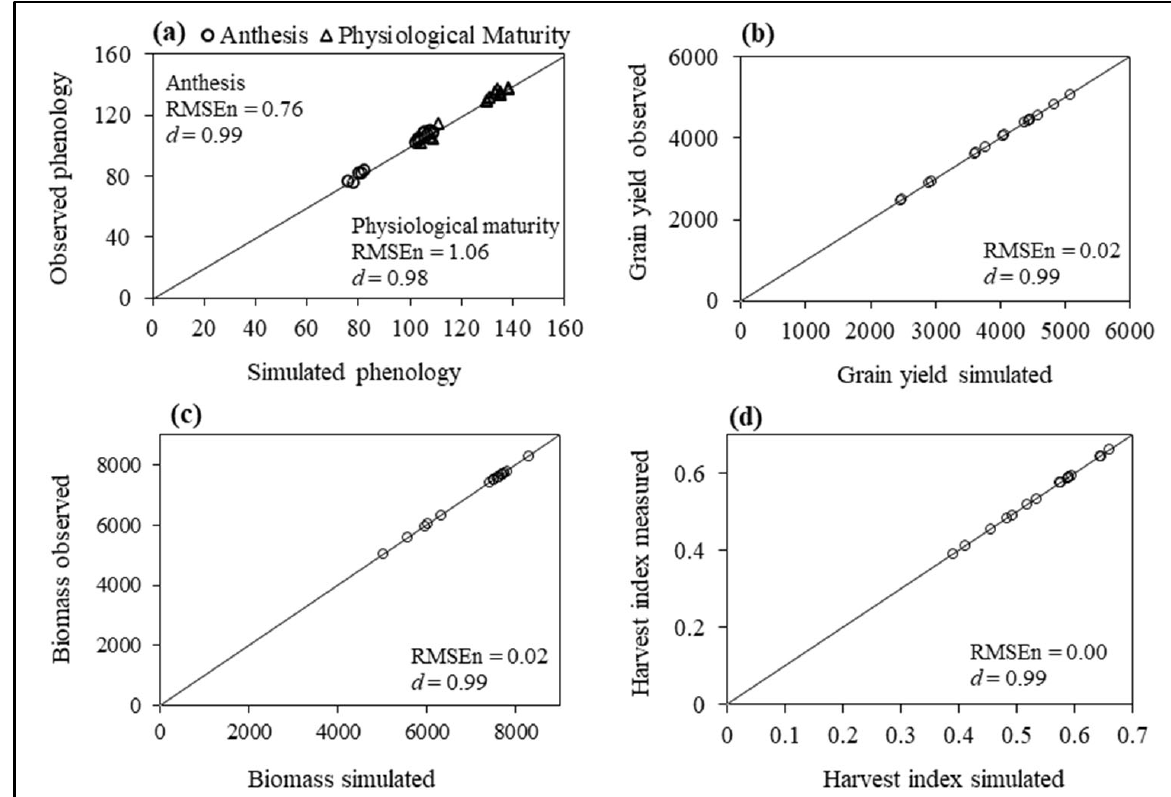
Figure 4. Simulated and observed anthesis (days) and physiological maturity [days] ( a ), grain yield (kgha –1 ) as dry matter ( b ), aboveground biomass (kg ha –1 ) as dry matter ( c ) and harvest index [%], and ( d ) for model calibration with data collected from the potential experiment conducted under optimum conditions.